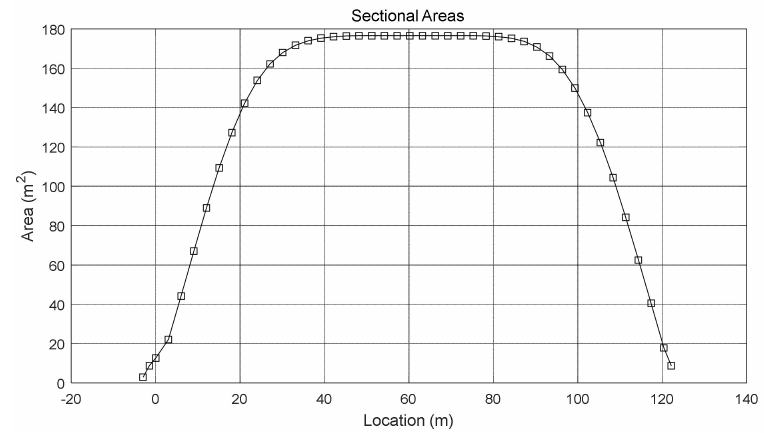
Figure 3. Sectional area depending on the longitudinal section location of the tanker.